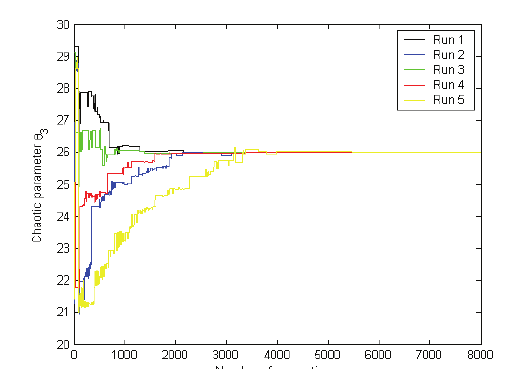
Fig. 6. Convergences of parameter runs (Run 1~Run 5).